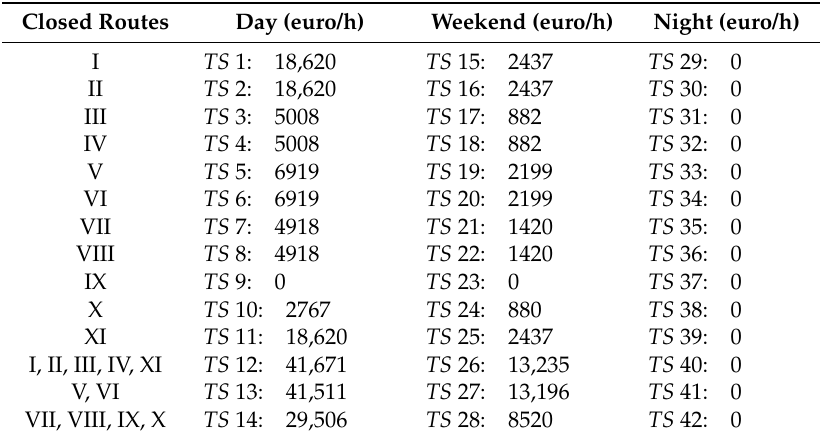
Table 7. Traffic states ( TS ).